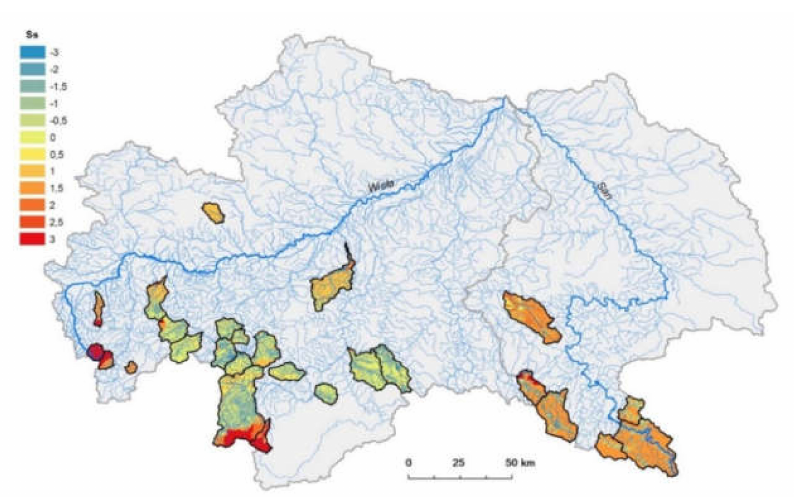
Figure 4. Soil types ( St ) of analyzed catchments in the Upper Vistula basin.